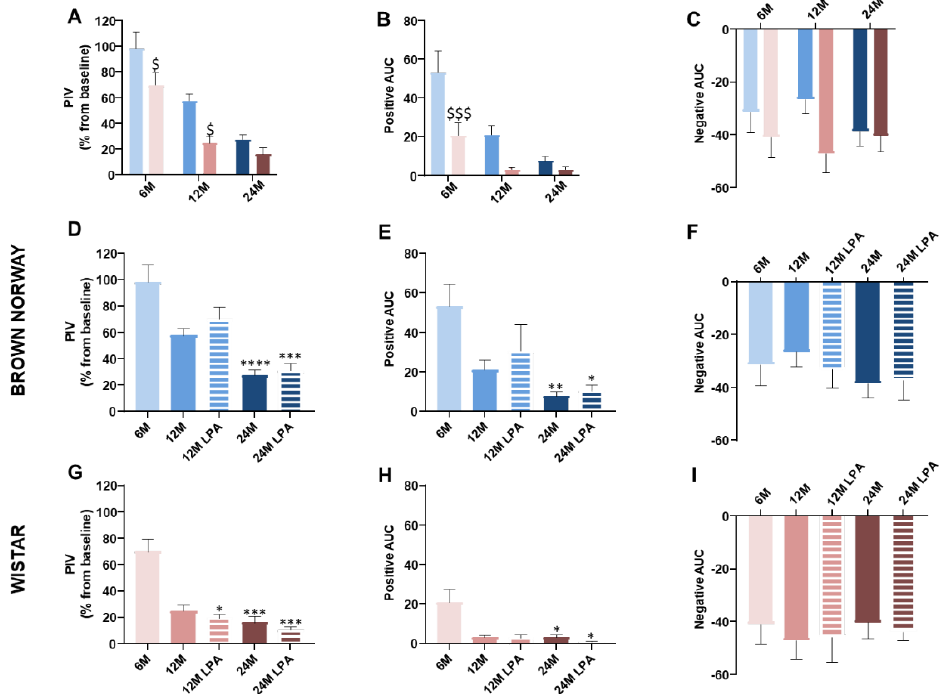
Figure 4. Skin ability to resist low pressure with (hatched lines/bars) or without (solid lines/bars) LPA treatment. The results were obtained for both BN (in blue) and Wistar (in pink) strains for 6 month old (6 M), 12 month old (12 M), and 24 month old (24 M) rats previously fed a diet supplemented with α -lipoic acid (0.5%) for 4 weeks (LPA) or not. The results were compared between the two strains ( A – C ) or within the BN strain ( D – F ) or Wistar strain ( G – I ). In addition to the skin blood flow changes in response to pressure application, the PIV ( D , G ), the positive AUC from baseline ( E , H ), and the negative AUC from baseline ( F , I ) were calculated for each strain in each condition and compared between the two strains ( A – C ). Error bars represent the standard error of the mean. Statistical analyses were performed revealing significant differences between the two strains for each age group ($ p < 0.05; $$$ p < 0.001 vs. BN strain) or within each strain during skin aging when compared to the 6 month condition (* p < 0.05; ** p < 0.01; *** p < 0.001; **** p < 0.0001).